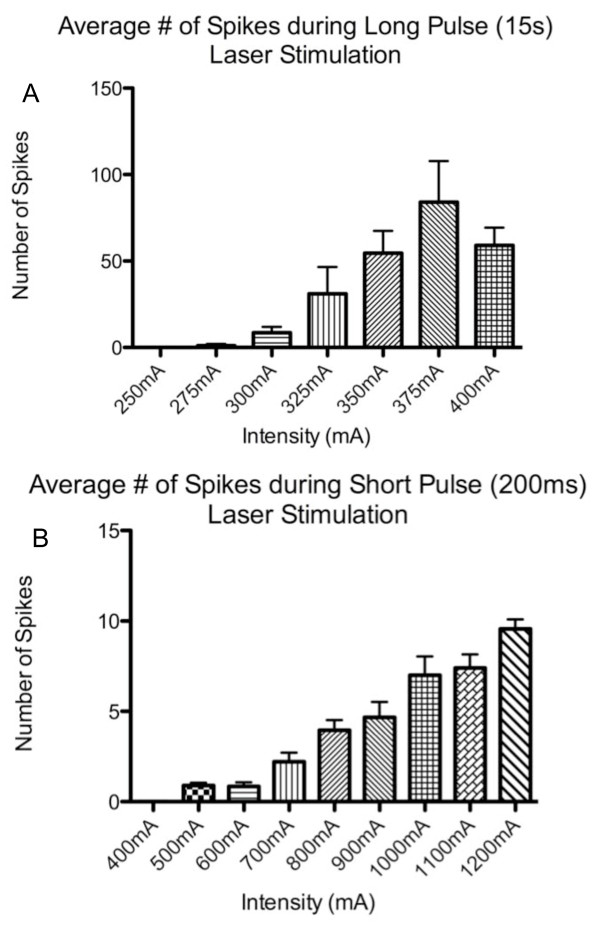
Intensity Response Distribution. Afferent neurons demonstrated a relatively linear increase in number of action potentials ("spikes") evoked in response to increasing laser stimulus intensity. This observation was true both for short, high power and long, lower power laser diode stimuli.